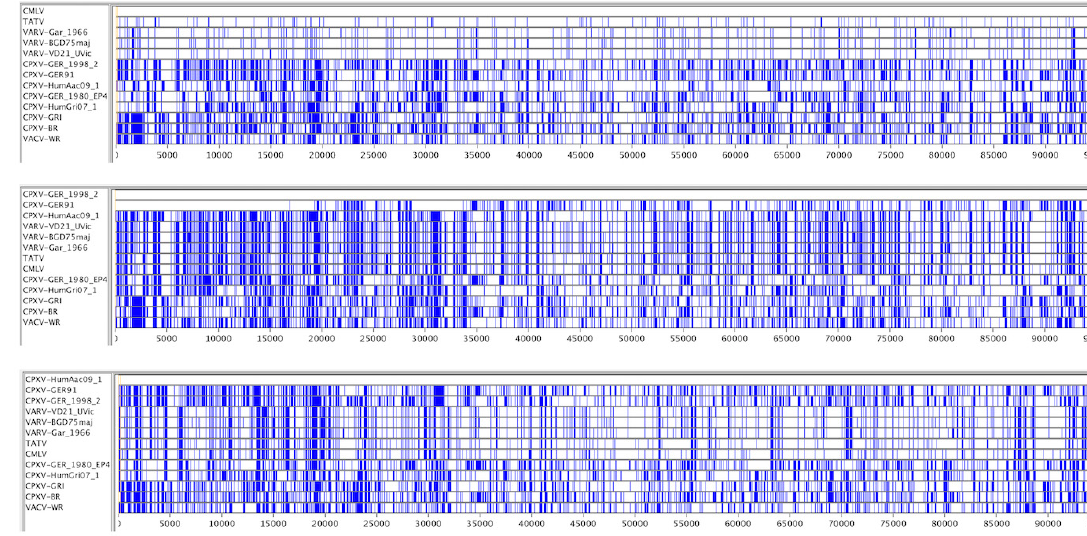
Figure 6. Base-By-Base (BBB) visual summaries of core alignments. SNPs unique to a single sequence have been converted to the consensus nucleotide, and gaps have been removed. Blue bars indicate a SNP; all sequences have been compared to the top sequence in each panel. Numbers refer to position in 98 kb alignment.